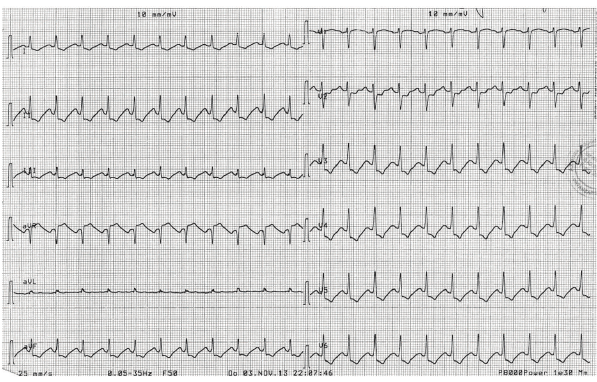
Figure 1: Explanation in the text.